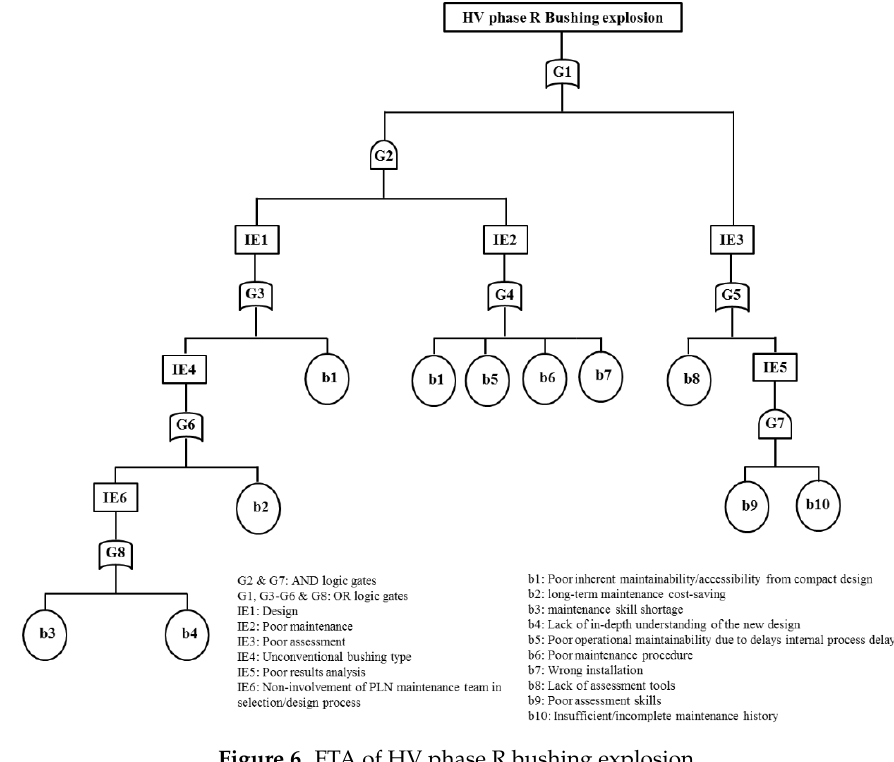
Figure 6. FTA of HV phase R bushing explosion.